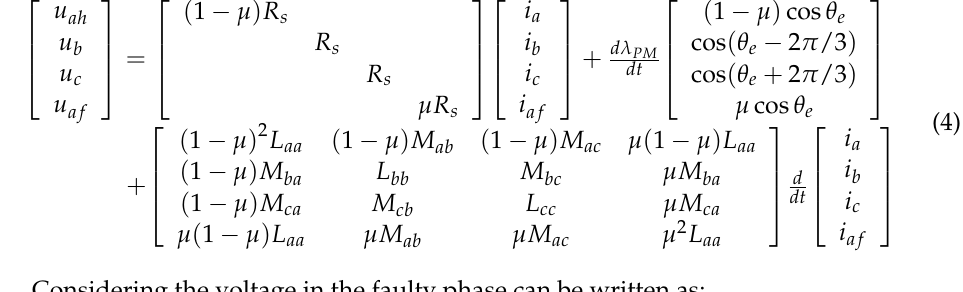
Considering there is only one branch in each phase winding, the electrical model of PMSG with ISF in phase a is shown in Figure 2. The faulty winding a is divided into the healthy and faulted parts. The faulted part is represented by a winding with resistance R af , inductance L af , and back EMF e af , and the current flow through it is defined as faulted current i af . The contract resistance in shorted path is defined as R f , with the short-circuit current i f flowing through it. The ratio of number of turns in faulted winding to the total number of turns per phase is defined as μ , which ranges from 0 to 1. The ratio μ and R f collectively represent the fault severity of the ISF. Under ideal conditions, the resistance Figure 2. Electrical model of PMSG with ISF in phase a. Figure 2. Electrical model of PMSG with ISF in phase a . and back EMF can be considered proportional to number of turns, and the inductance is proportional to the square of turns. Thus, the parameters both in the healthy and faulted From reference [30], the mathematical model of PMSG with ISF can be expressed in (4), parts can be calculated accordingly. where R s is stator resistance, θ e is electrical angle. L and M are self and mutual inductance of stator winding respectively, λ PM is the PM flux